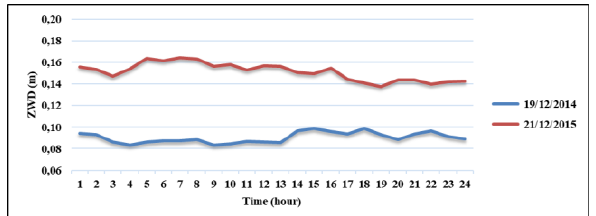
Figure 9. PM 10 time series of Zonguldak.